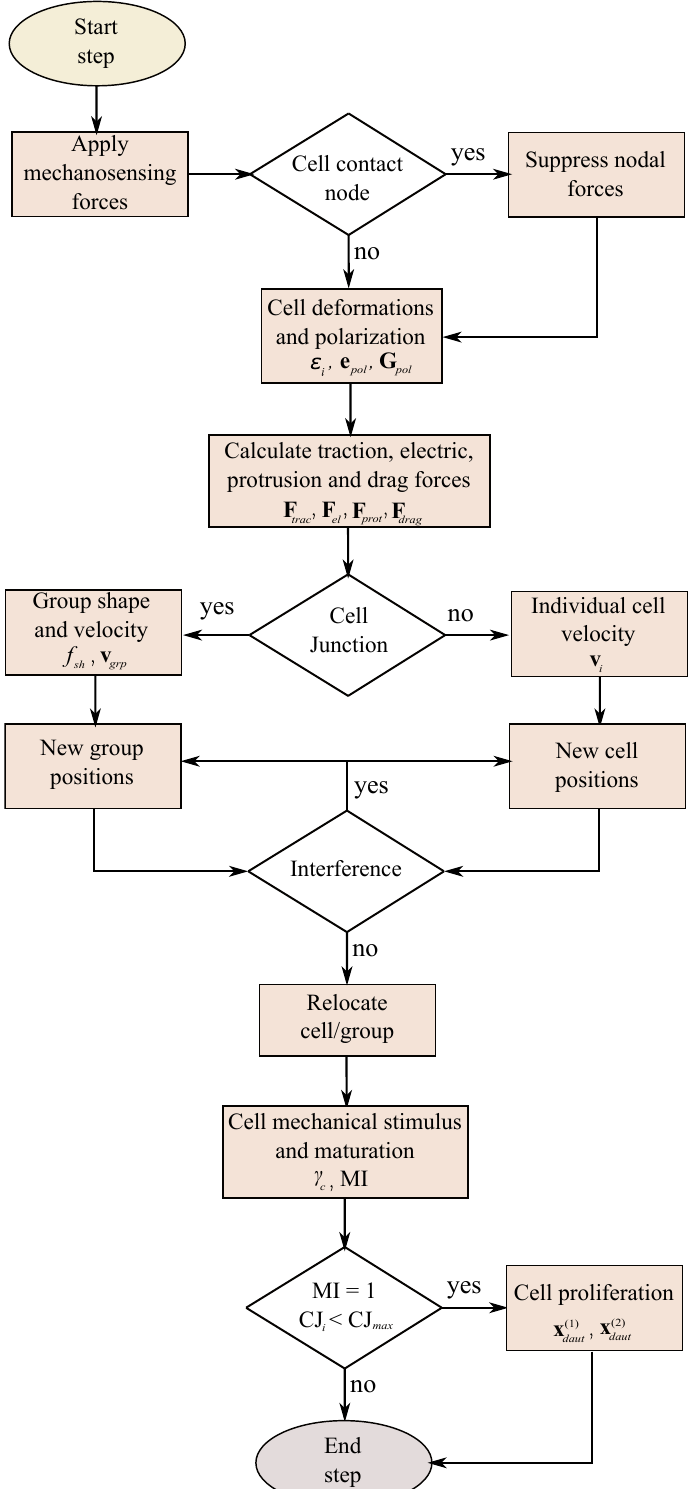
Figure 5. Algorithm of the model implemented for each time